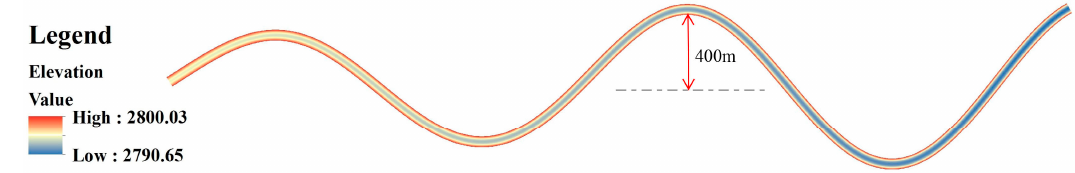
Figure 7. Synthetic sinusoidal river with the amplitude of 400 m. Unit: m.